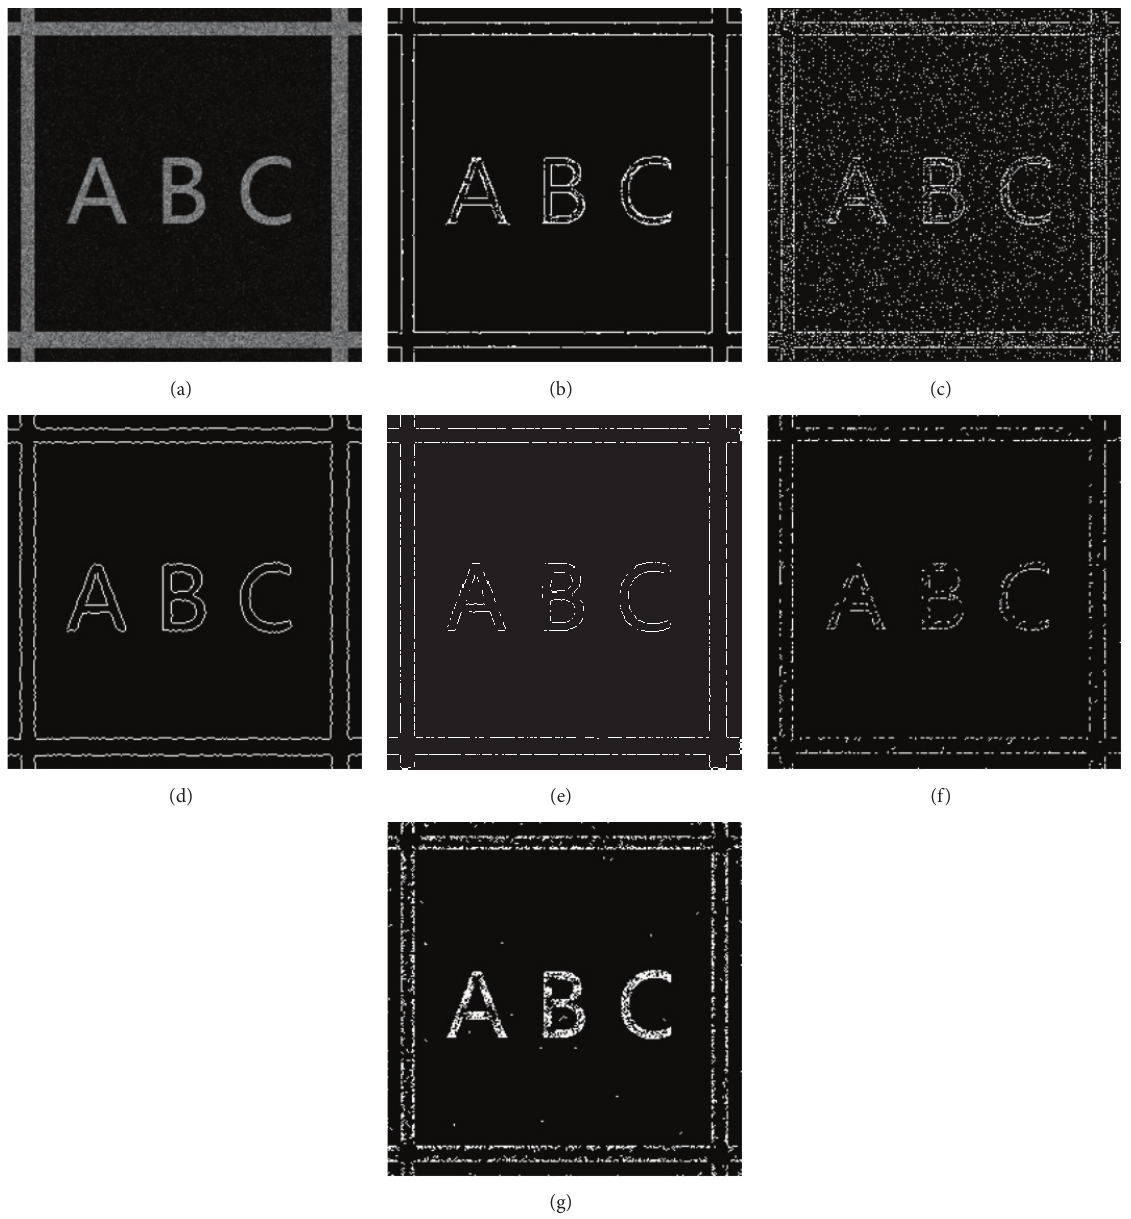
Figure 4: The results of the edge detection: (a) the synthetic image, (b) the proposed method, (c) the method based on CNN, (d) Canny operator, (e) Sobel operator, (f) wavelet method, and (g) NSCT method. Table 1: The FOM calculations with different methods. Figure